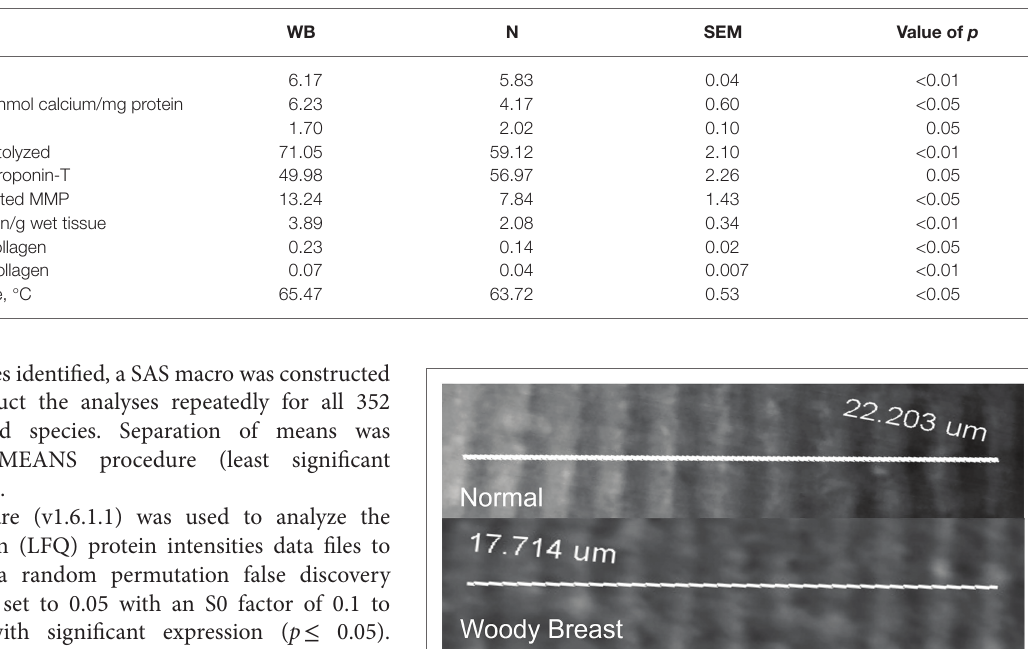
TABLE 1 | Effects of woody breast (WB) myopathy on pH, free calcium concentration, sarcomere length, calpain activity, proteolysis, collagenase activity, collagen content, pyridinoline (PYD) density, deoxypyridinoline (DPD) density and connective tissue peak transitional temperature compared to normal (N) Pectoralis major from broilers.